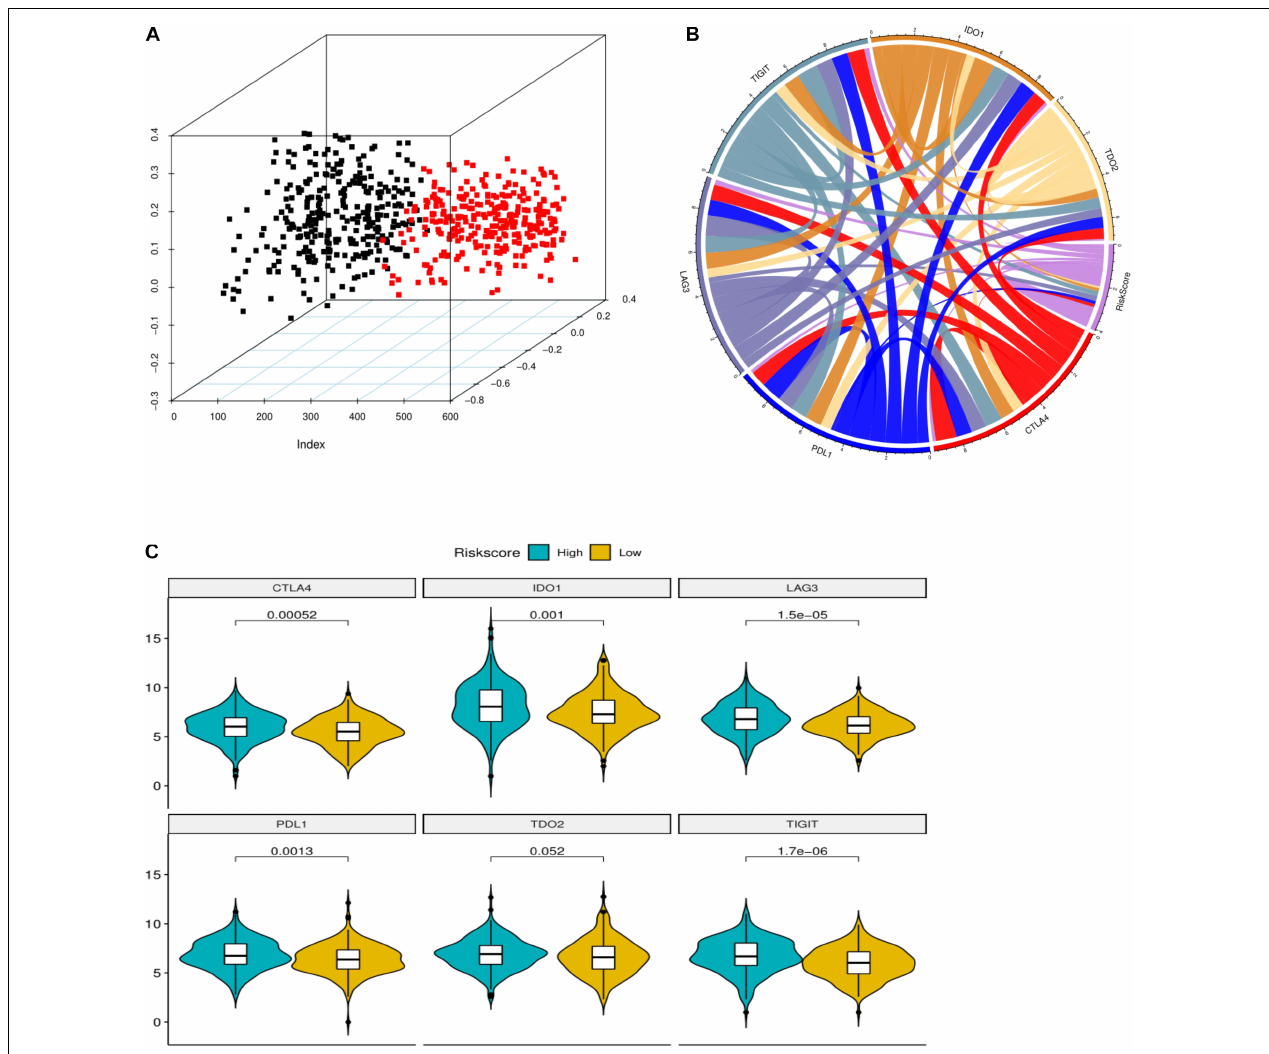
FIGURE 7 | (A) PCA three dimensional clustering diagram. Different color points represented different types of samples. (B) Correlation chord maps (Chord diagram) of risk scores with six prominent immune checkpoint expression, the more connections between them represent the stronger correlation between them. (C) The immune checkpoint violin diagram with significant difference in expression in high and low risk groups. Different colors represent high and low risk groups. The longitudinal axis is the expression amount. The p -value is calculated by wilcoxon